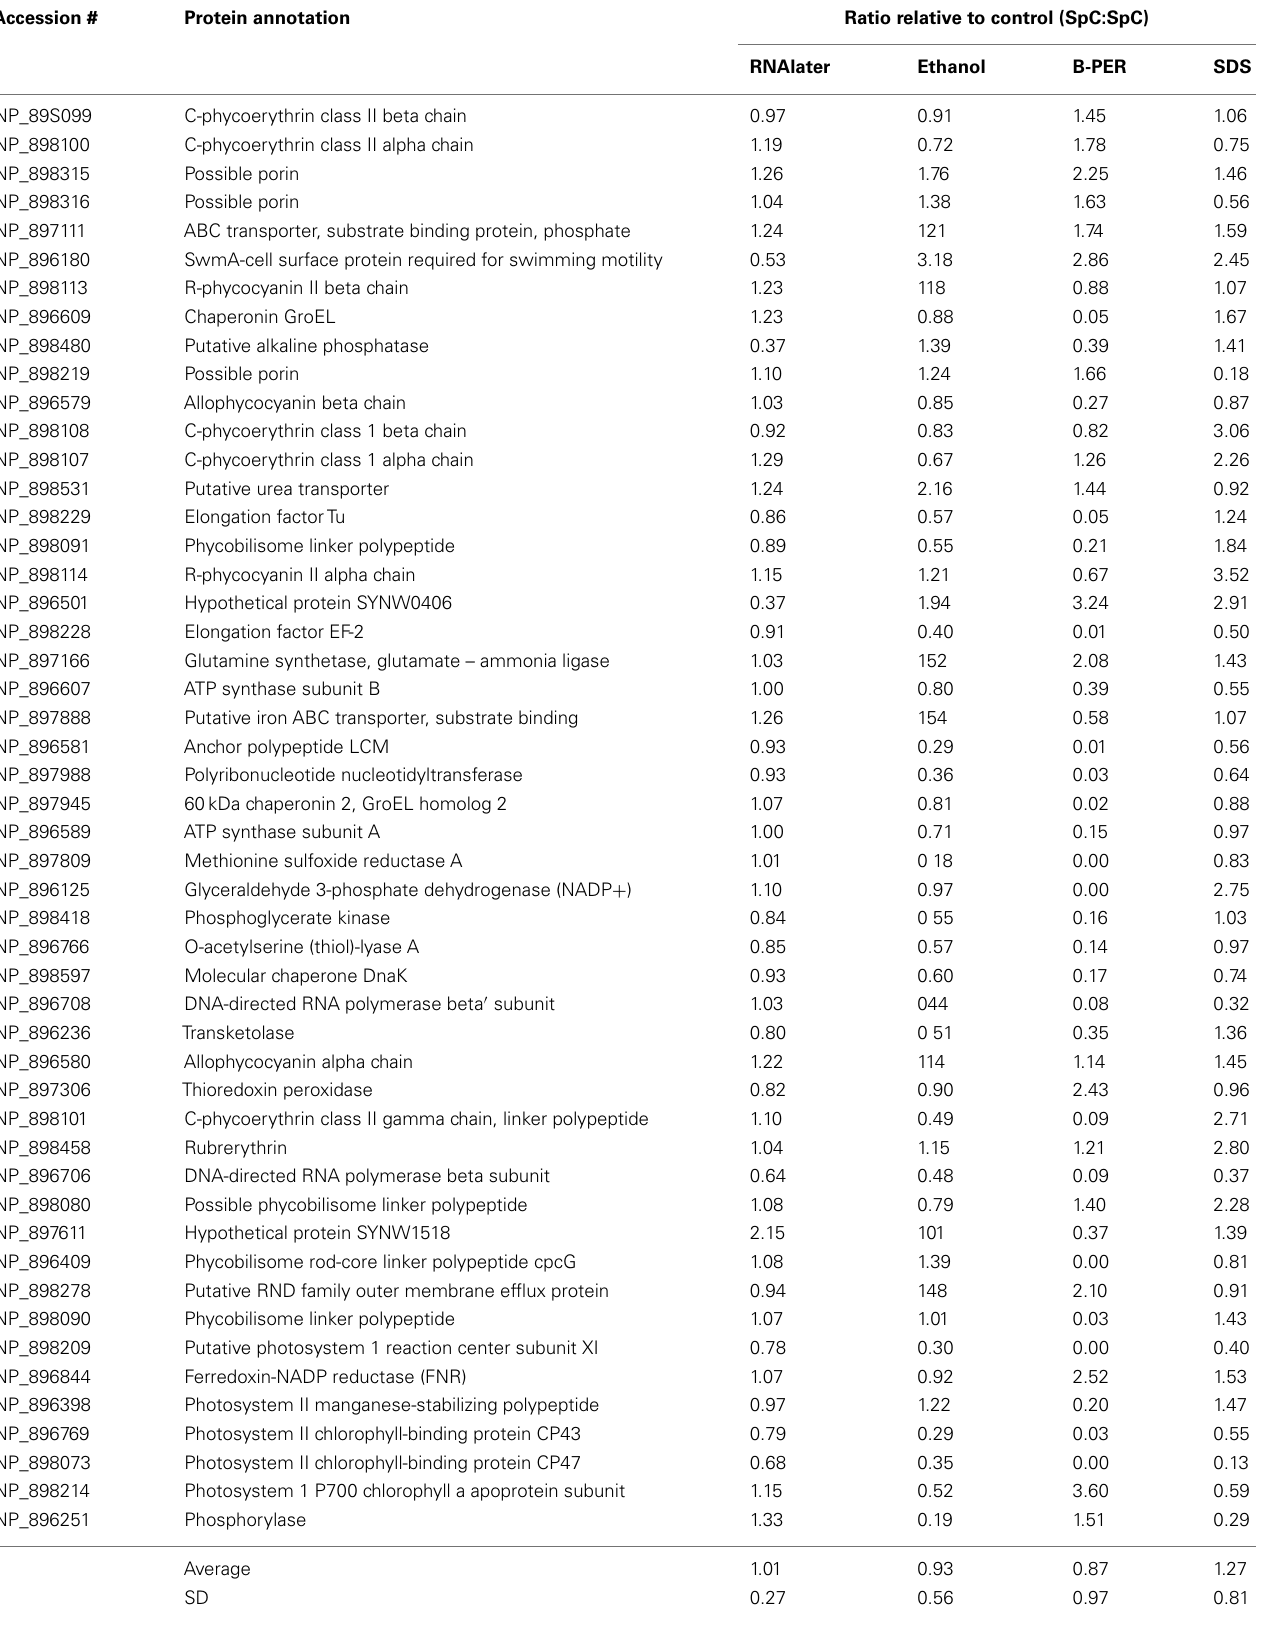
Table 2 | Changes in relative abundance of 50 most abundant proteins during preservation (linear